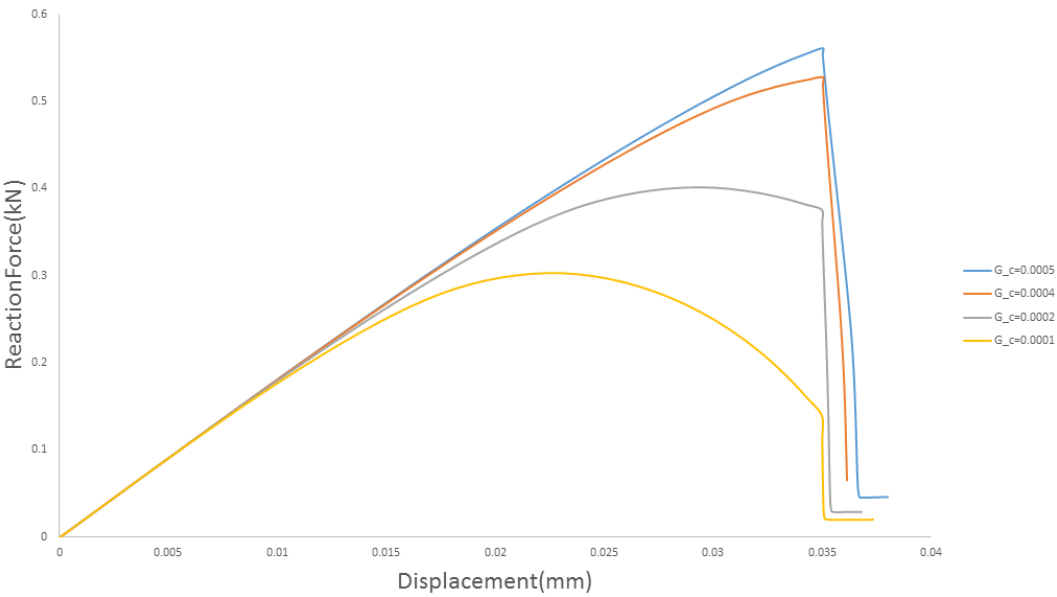
Figure 5. Load–displacement curves for varying G c